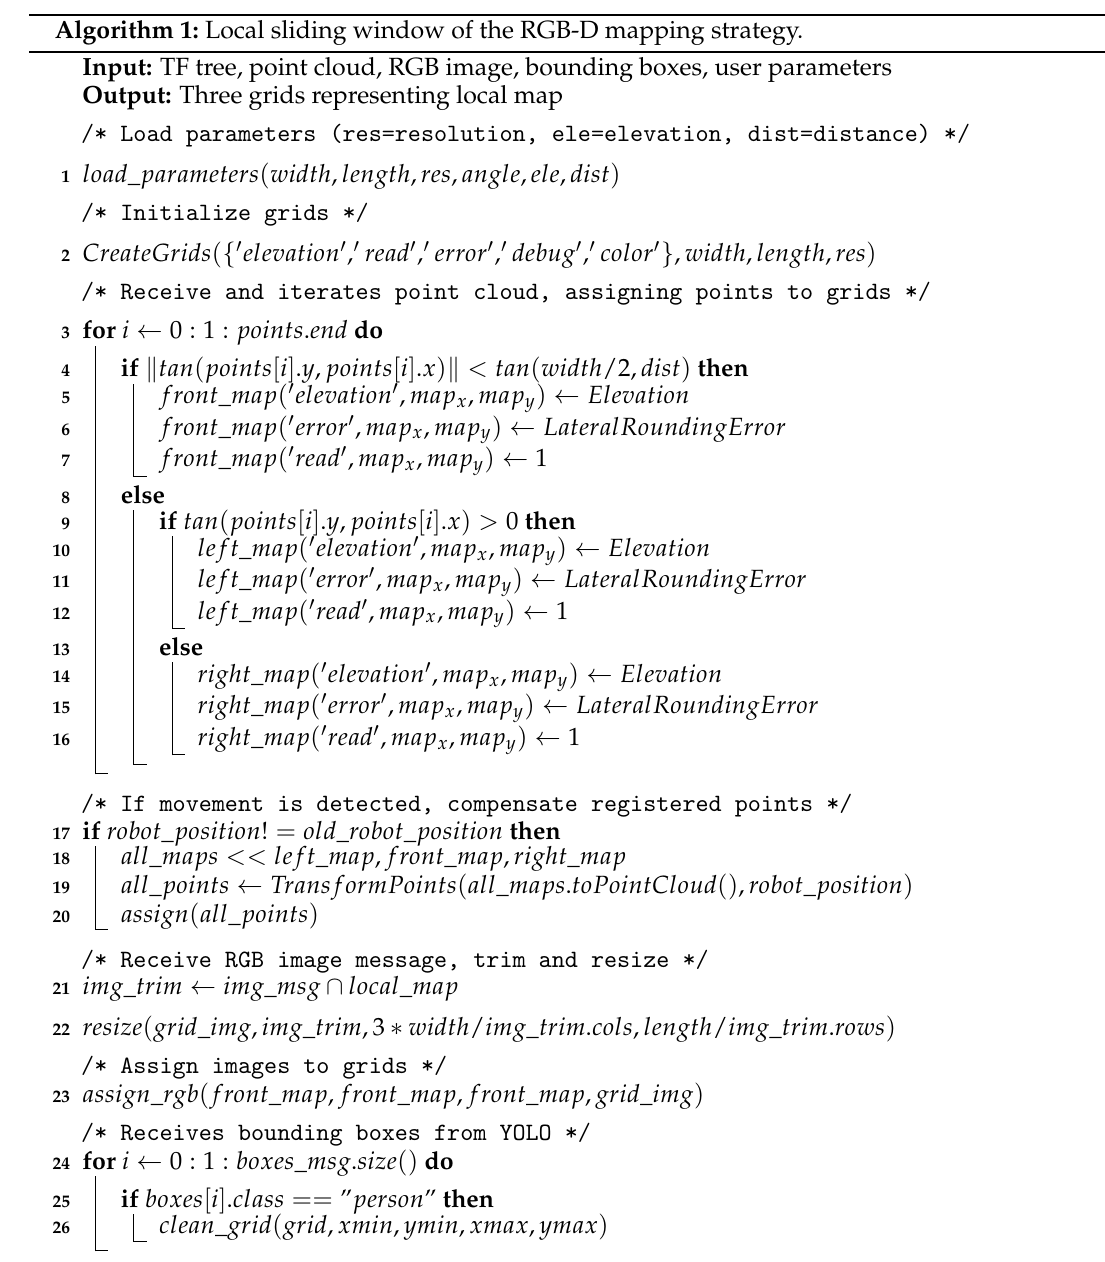
Algorithm 1: Local sliding window of the RGB-D mapping